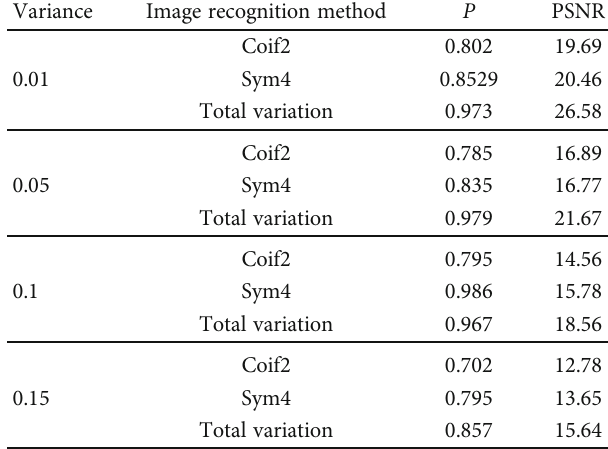
Table 1: Performance analysis of wavelet threshold and nonlinear total variation image